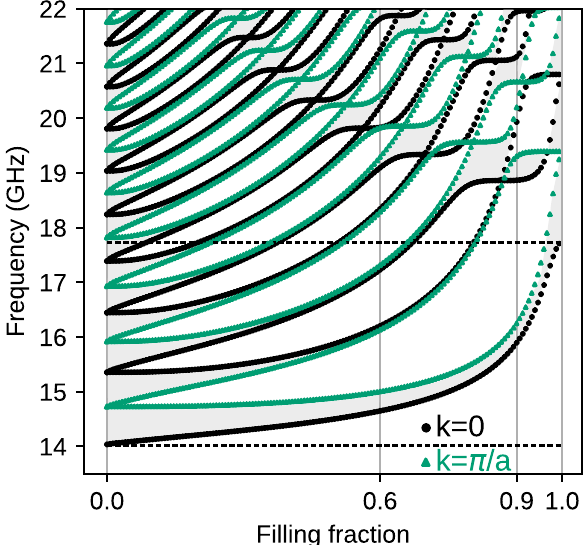
Figure 5. The evolution of dipolar-exchange SW spectra in dependence on the bulk parameter: filling fraction 0.6, 0.9 denote the pair of 1D MCs, that were interfaced. We used 1000 nm). The vertical lines at ff ff ( a = = the same convention to mark frequency bands, gaps and their edges as in Fig. 2. The higher (lower) horizontal dashed line marks the FMR frequency for uniform Co (Py)